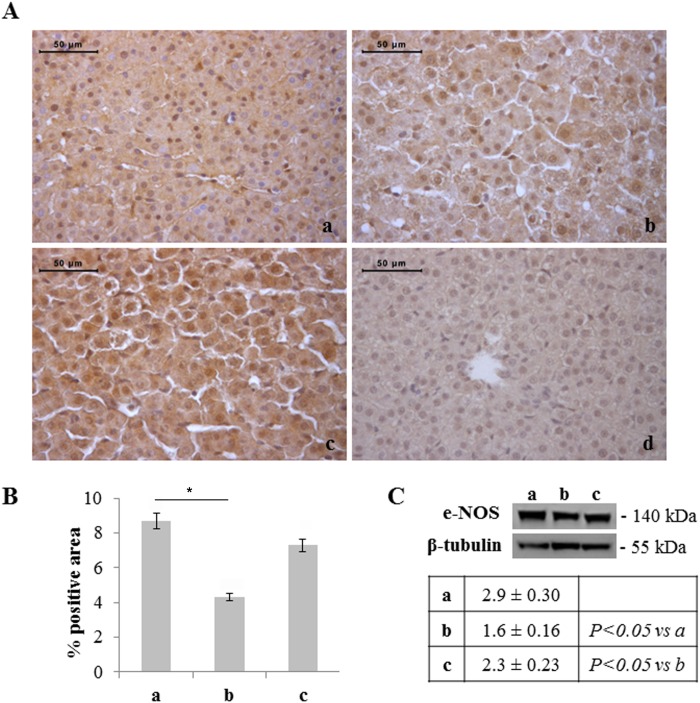
Moderate hyperoxia reduces hepatocyte eNOS expression with respect to normoxia and severe hyperoxia.A) Immunohistochemical detection of eNOS expression in neonatal rat livers exposed to moderate and severe hyperoxia. a) ambient air; b) 60% hyperoxia; c) 95% hyperoxia; d) negative control; scale bar: 50 µm, magnification 40x. B) Graphic representation of the percentage of eNOS positive area (±SD); densitometric analysis determined by direct visual counting of ten fields for each of three slides per sample. * = p<0.05. C) Western blotting analysis of eNOS expression in neonatal rats. Each membrane has been probed with anti β-tubulin antibody to verify loading evenness. The most representative out of three separate experiments is shown. Data are the densitometric measurements of protein bands expressed as mean values of Integrated Optical Intensity (IOI) (±SD).